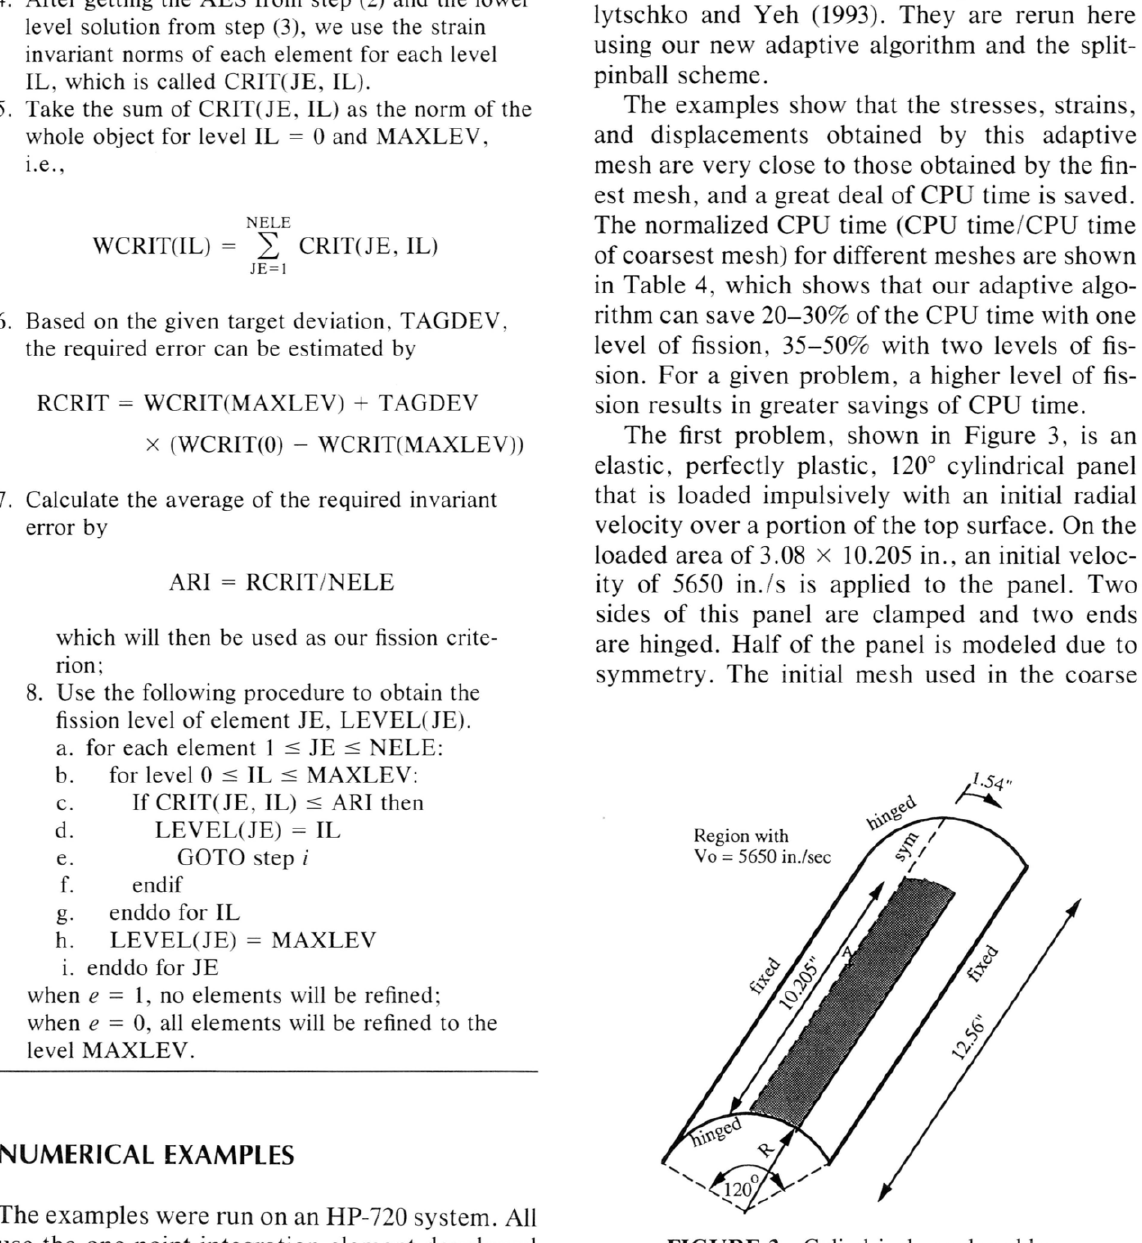
FIGURE 3 Cylindrical panel